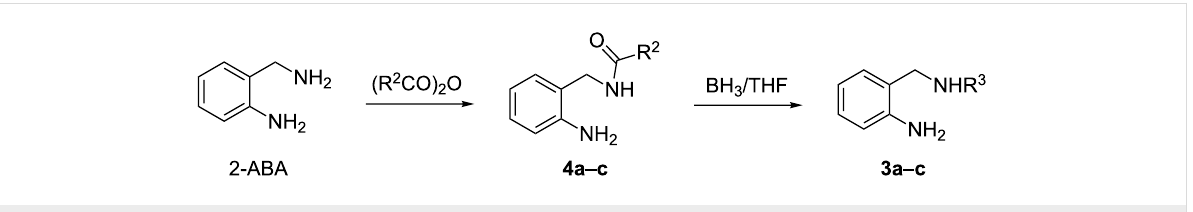
Scheme 2: Synthesis of compounds 3a – c